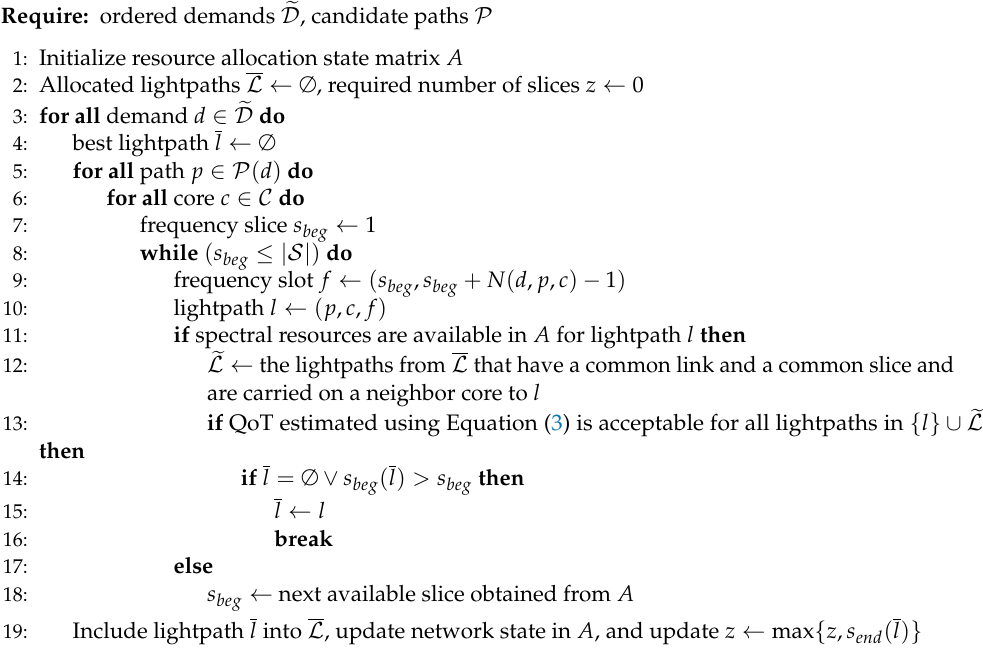
Algorithm 1 returns a feasible allocation of lightpaths after processing the